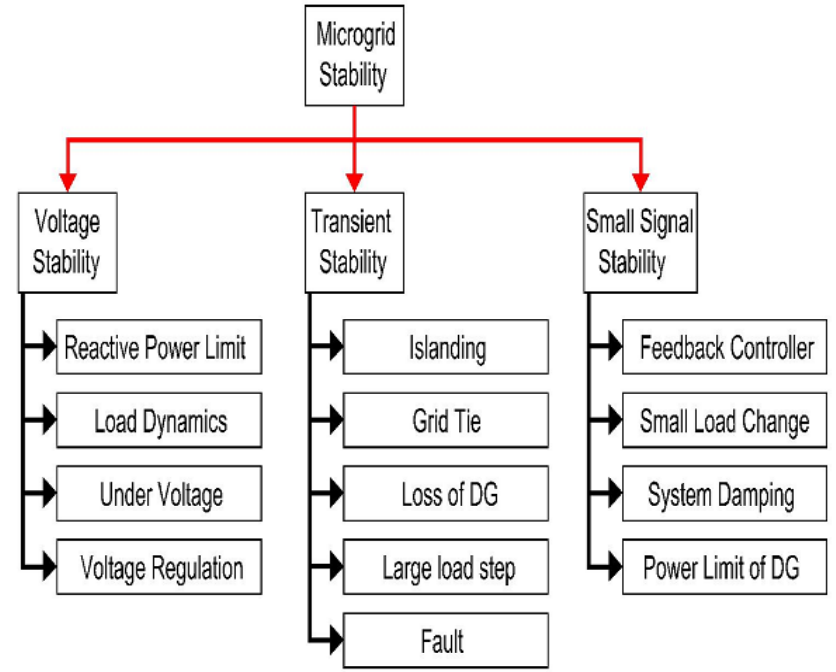
Figure 2. Issues of stability in MG and their reasons.